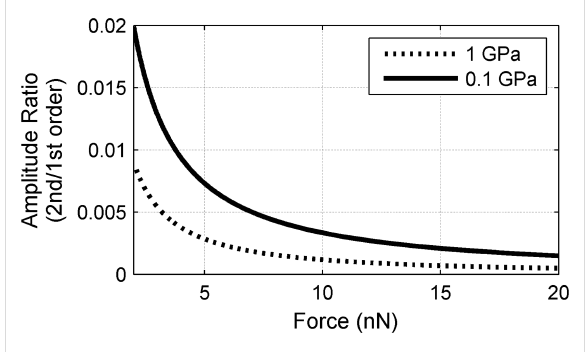
Figure 1: Amplitude ratio of the second to the first harmonic, plotted for different applied forces. The surface modulus is set to 0.1 GPa (solid) and to 1.0 GPa